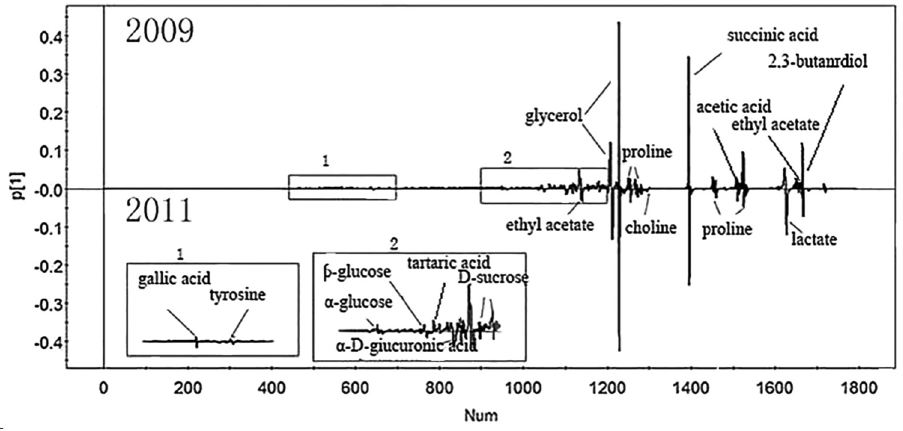
Figure 8: PLS - DA loading plot chart from 1 H NMR spectra of 2009 and 2011 vintage Cabernet Sauvignon